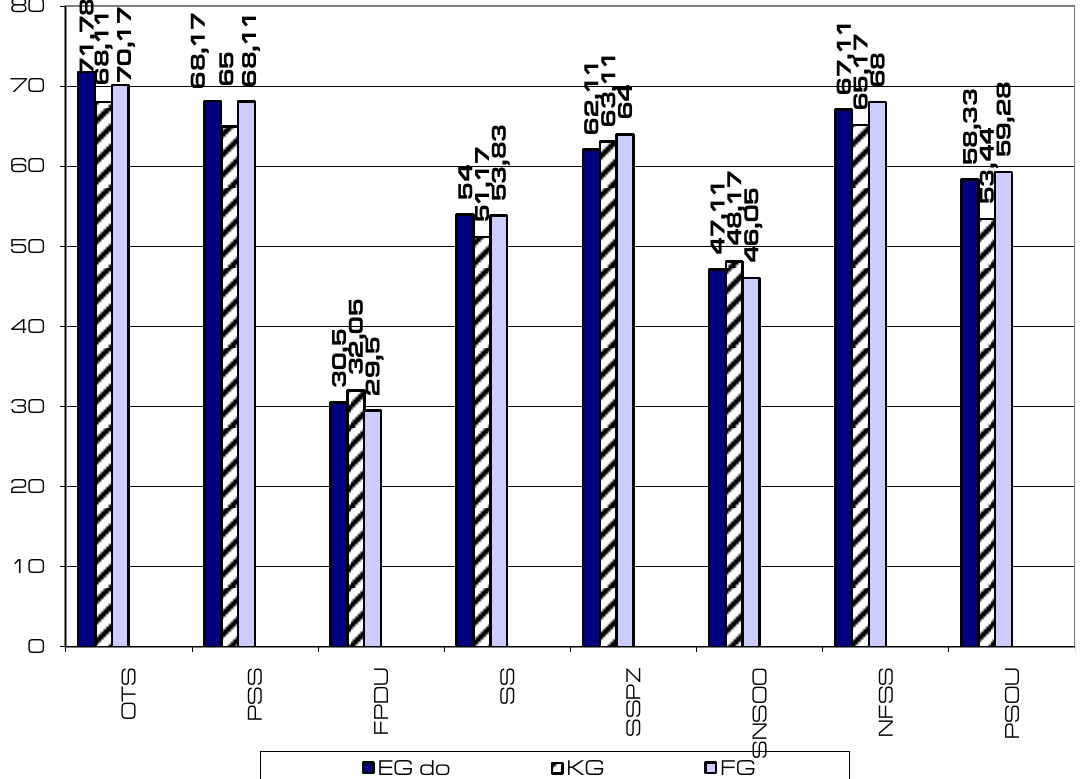
Fig.1. Mean indicators of test for school anxiety (Fillips” test) of experimental, control and background groups before pedagogic experiment